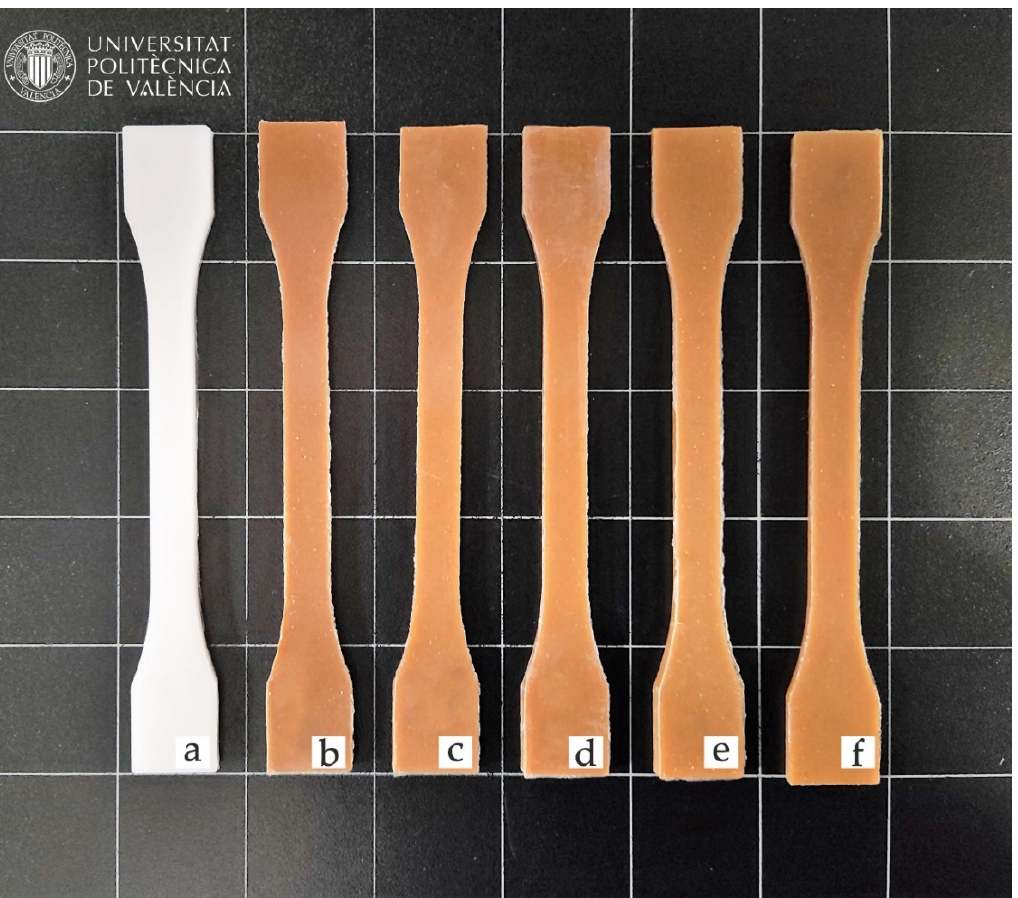
Figure 6. Visual appearance of the samples: ( a ) neat BioPBSA; ( b ) BioPBSA/HEMP; ( c ) BioPBSA/HEMP/7.5DBI; ( d ) BioPBSA/HEMP/15DBI; ( e ) BioPBSA/HEMP/PBSA- g -IA; ( f ) BioPBSA/HEMP/PBSA- g -MA.